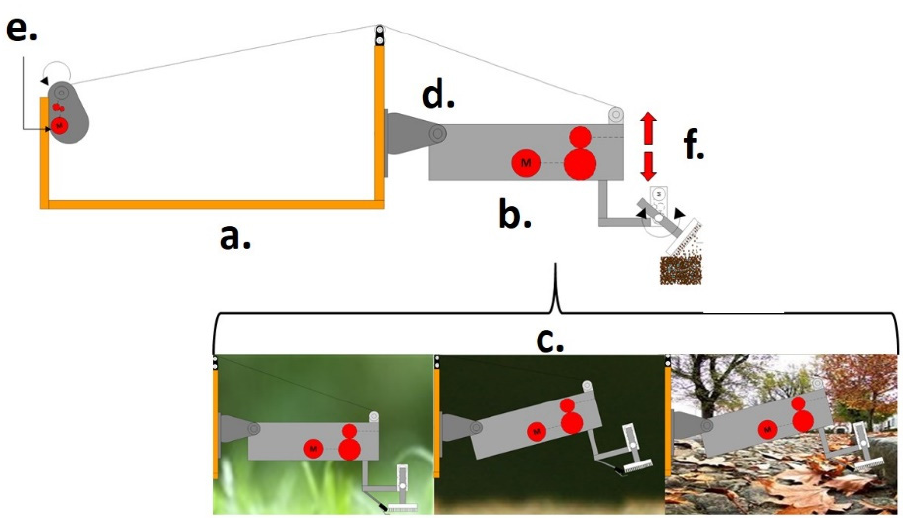
Figure 1. Schematic diagram of the platform’s locomotion system. ( a ) Mechanical structure; ( b ) Probe; ( c ) Sceneries of operation; ( d ) Knee-cap; ( e ) Electric motor; ( f ) Climb and descent movement.